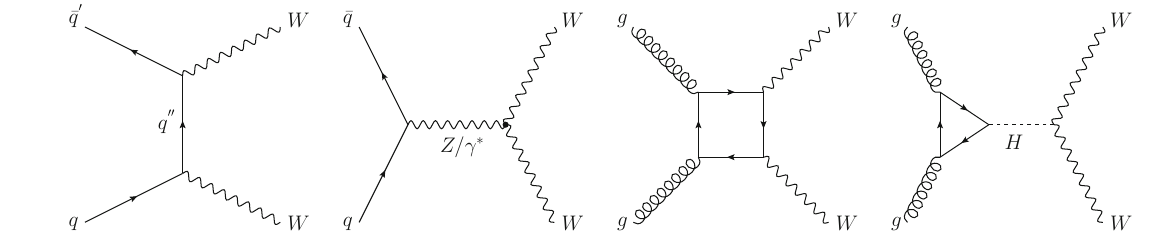
Fig. 1 Feynman diagrams for SM WW production at tree level (from left to right): q ¯ q initial-state t -channel, q ¯ q initial-state s -channel, gg initial-state non-resonant and gg initial-state resonant production. The s -channel production contains the WW Z and WW γ triple-gauge-